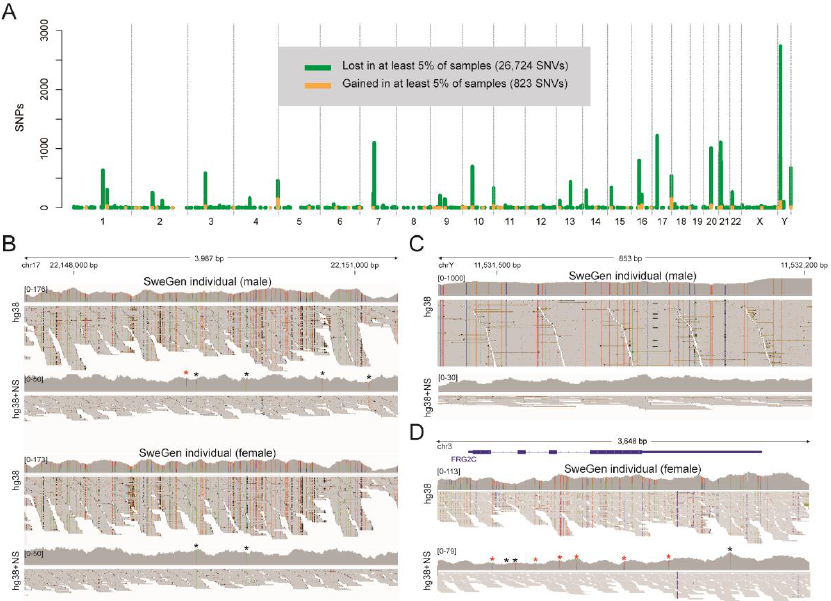
Figure 5. A novel reference gives improved alignment and SNV calling of SweGen WGS data. (A ) Genomic distribution of SNVs that are lost (green) and gained (orange) when NS are appended to the hg38 reference. Only non-centromeric SNVs that are lost/gained in at least 5% of the 200 SweGen samples are shown in this figure. ( B ) An IGV [31] view of Illumina reads for two representative SweGen samples at a region on chr17, where some SNVs are lost and others are gained when using the hg38+NS reference. Illumina data is shown for a male and a female (not the same individuals as Swe1 and Swe2). Both for the male and female, the coverage decreases over the region when NS are appended to hg38, and about 100 (homozygous) false positive SNV calls are lost in each of the samples. Only five heterozygous SNVs where found for the male individual when the novel reference was used, and two homozyogous SNVs for the female (marked by asterisks ‘*’). A red asterisk indicates a gained SNV that is not detected in hg38. ( C ) An example region on chrY where the coverage was reduced from almost 1000 × to below 30 × when using hg38+NS, and where a large number of SNVs were lost. Only data for the male individual is shown in this panel. ( D ) Improved alignment and SNV calling over the FRG2C locus on chromosome 3. A large number of SNVs were lost, and six SNVs were gained (red asterisks ‘*’), in the female SweGen sample. Some of the lost and gained SNVs are located in the coding sequences of FRG2C